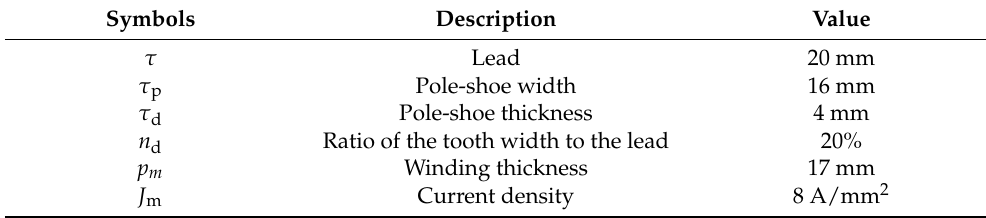
Figure 11. The thrust force comparison between the novel EMLS and normal MLS. Table 2. Designed parameters.